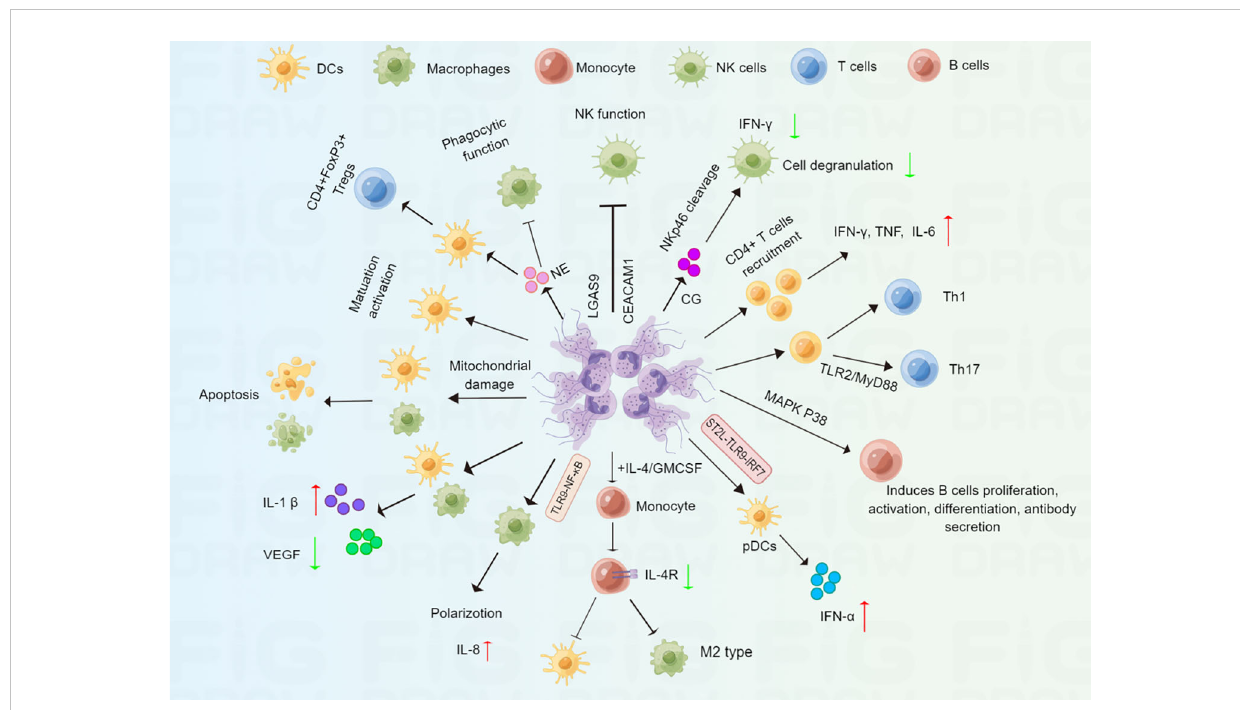
FIGURE 3 Schematic representation of NET in regulating immune cells. NETs can mediate immune response via complex regulations at multiple immune cells. Macrophages and DCs: NETs promote macrophages apoptosis, polarization, cytokine production, and impair macrophage phagocytic function; NETs can promote DCs apoptosis, maturation, activation and cytokine production. NK cells: NETs can impair NK cell function, including IFN- g production and cell degranulation. T cells: NETs promote CD4+ T cell differentiation into Th1 and Th17 cell; NETs also promote immature DCs differentiation into CD4+FOXP3+Tregs.B cells: NETs can induce B cells proliferation, activation, differentiation and antibody